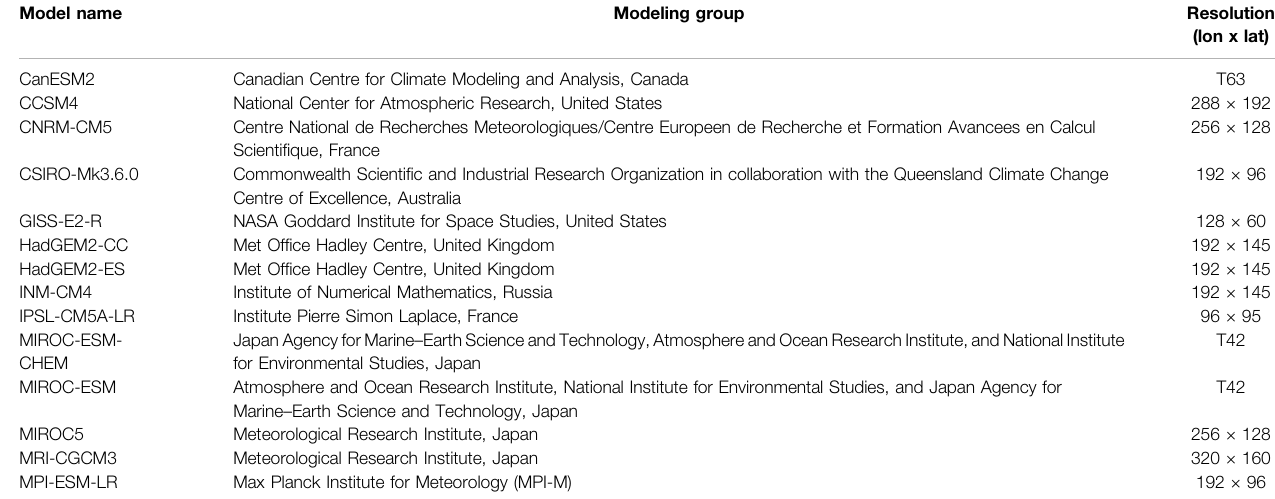
TABLE 1 | ist of CMIP5 models used in this